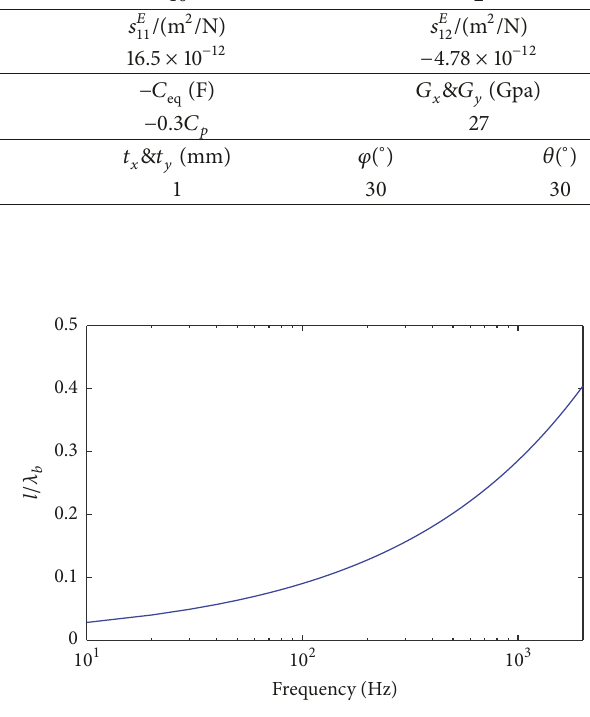
Figure 7: The ratio ( 𝑙/𝜆 𝑏 ) of the lattice constant to the flexural